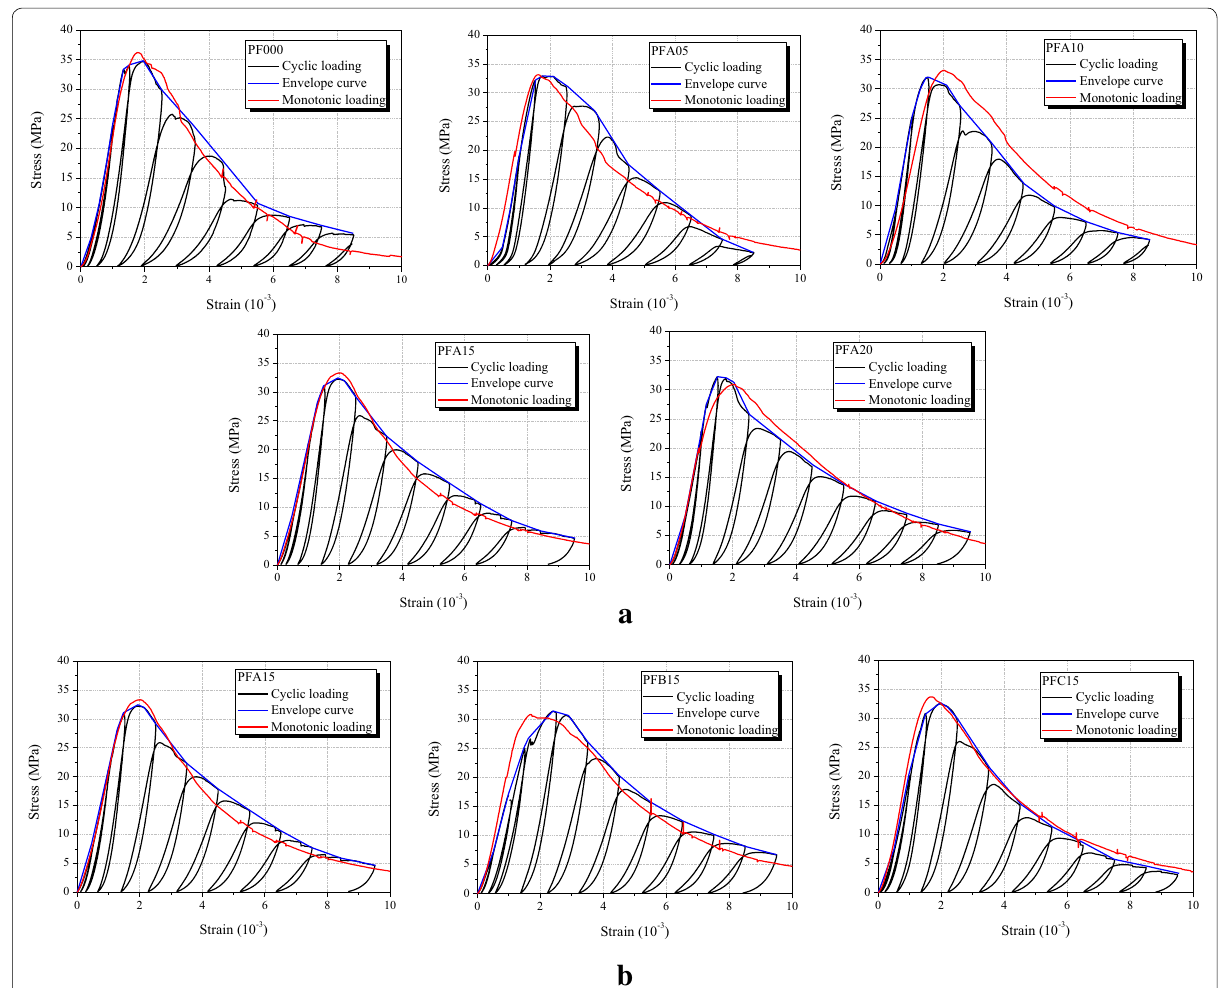
Fig. 6 Cyclic compressive stress–strain curves of PFRC. a Effect of fiber volume fraction, b Effect of fiber aspect ratio.